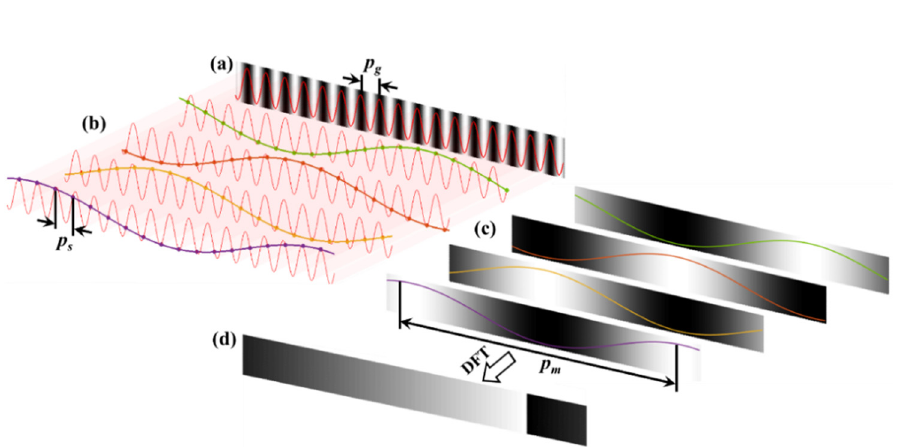
Figure 1. The flow chart of the sample moiré method. ( a ) Fringe image, ( b ) Sampled points in the fringe image, ( c ) Multiple phase-shifted sampling moiré patterns obtained by sampled point interpolation, ( d ) The phase distribution of the initial sampling moiré pattern.